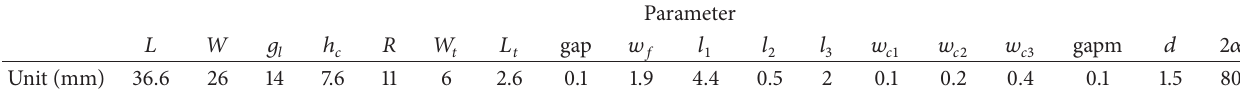
Table 1: Optimized parameters of the proposed antenna.